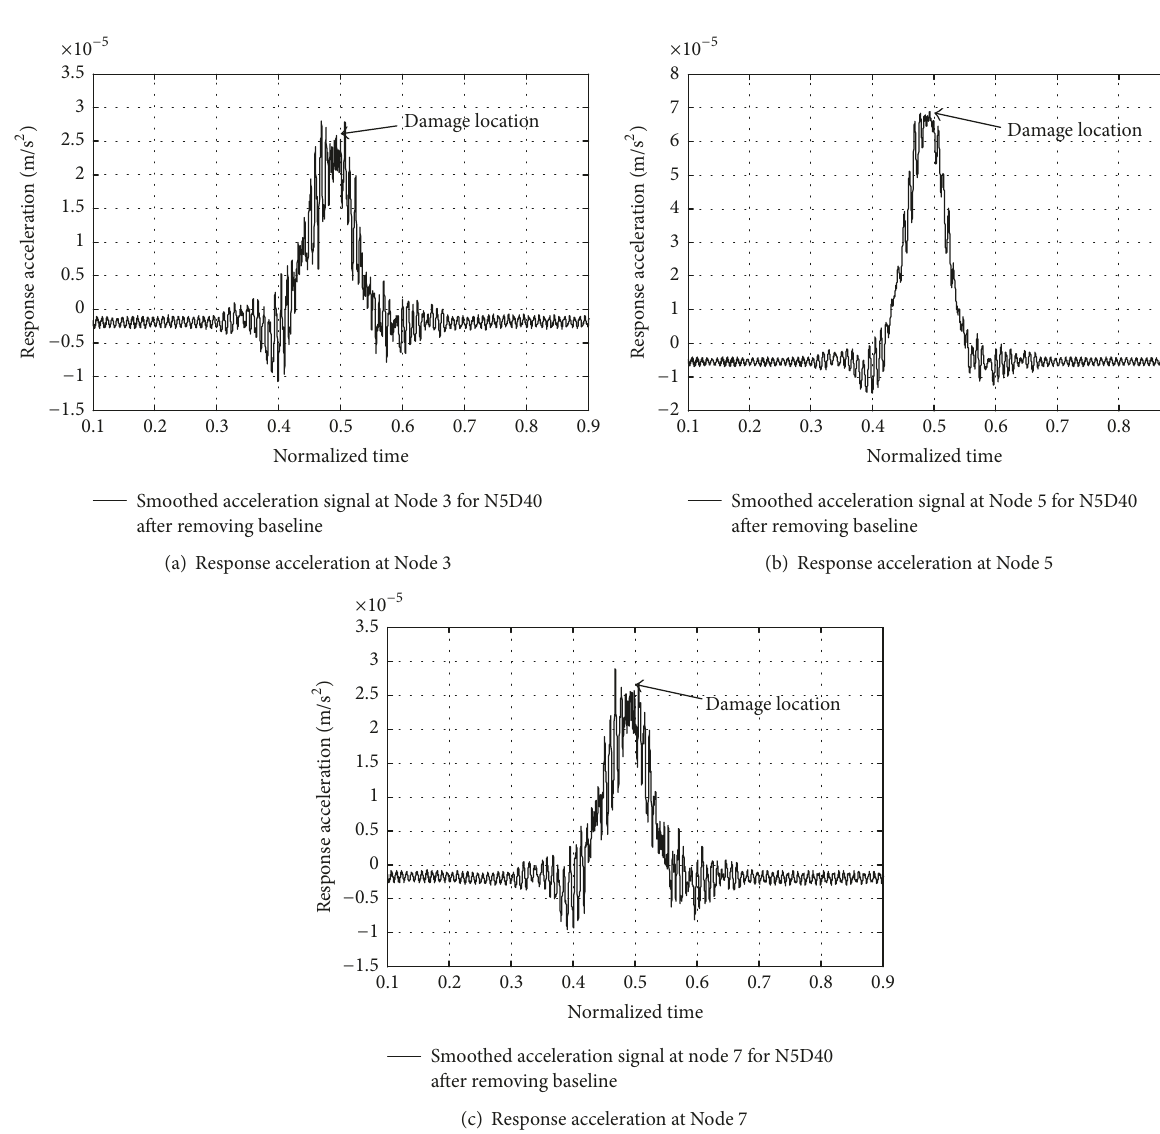
Figure9:Thesmoothedaccelerationsignalafterremovingthebaseline(thedamageoccurredinthemiddleofthebeam)atdifferentlocations: (a) signals from Node 3, (b) signals from Node 5, and (c) signals from Node 7.